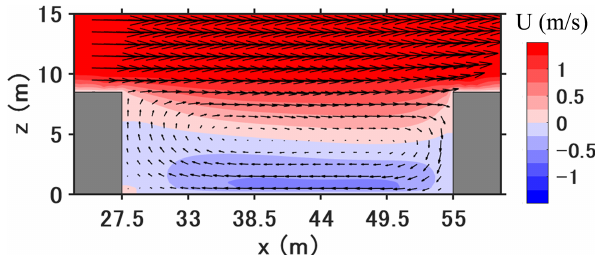
Figure 11. Time-averaged flow field in the street canyon from 05:00LT to 17:00LT.